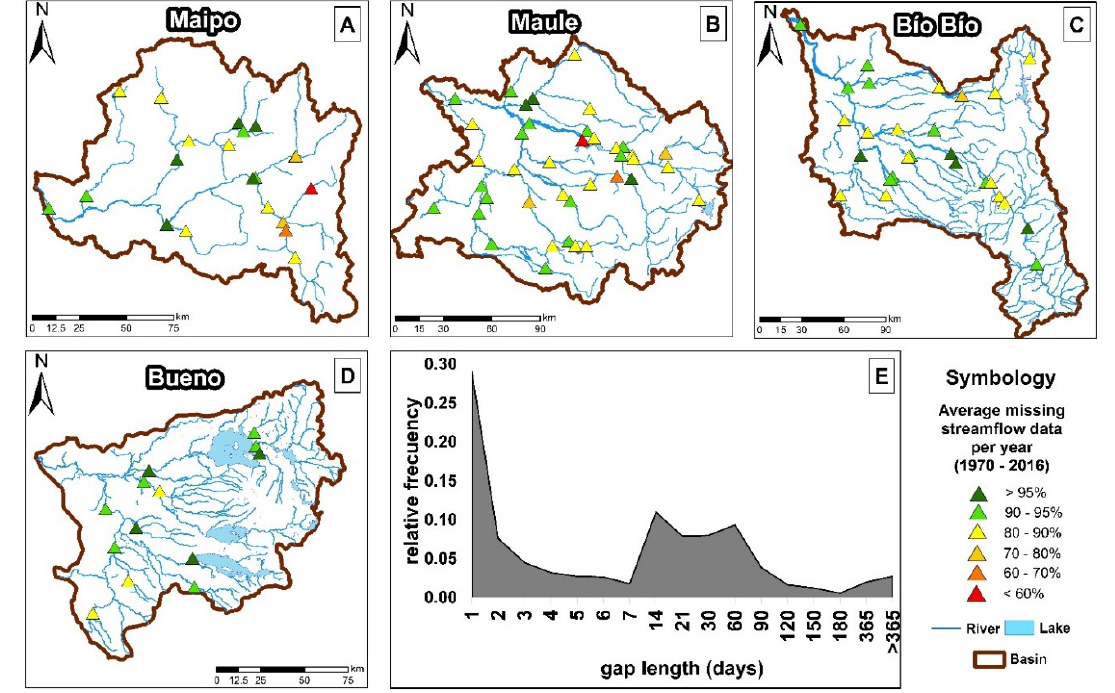
Figure 3. Available streamflow data between 1970 and 2016 in ( A ) Maipo, ( B ) Maule, ( C ) B í o B í o and ( D ) Bueno. ( E ) Gap